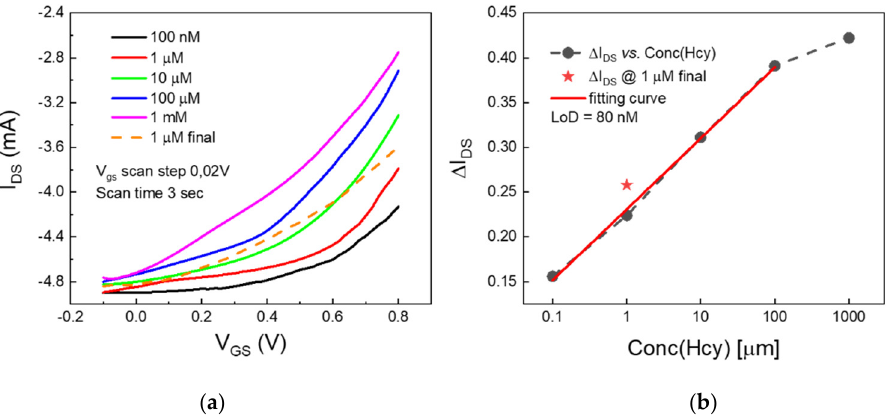
Figure 4. ( a ) (solid lines) OECT transfer curves measured after the gate gold electrode incubation in Hcy:HCl:PBS solutions with progressively-increased Hcy concentrations (from 100 nM (black curve) to 1 mM (magenta curve); the dotted orange curve was measured at the end of this set of measurements and using a gold electrode incubated at 1 μ M of Hcy. ( b ) The IDS modulation parameter, defined as [(IDS(@VGS = 0.8 V) − (IDS(@VGS = 0.1 V)]/(IDS(@VGS = 0.1 V), extracted from all the recorded transfer curves in panel ( a ), as a function of the Hcy concentration in Hcy:HCl:PBS solutions.